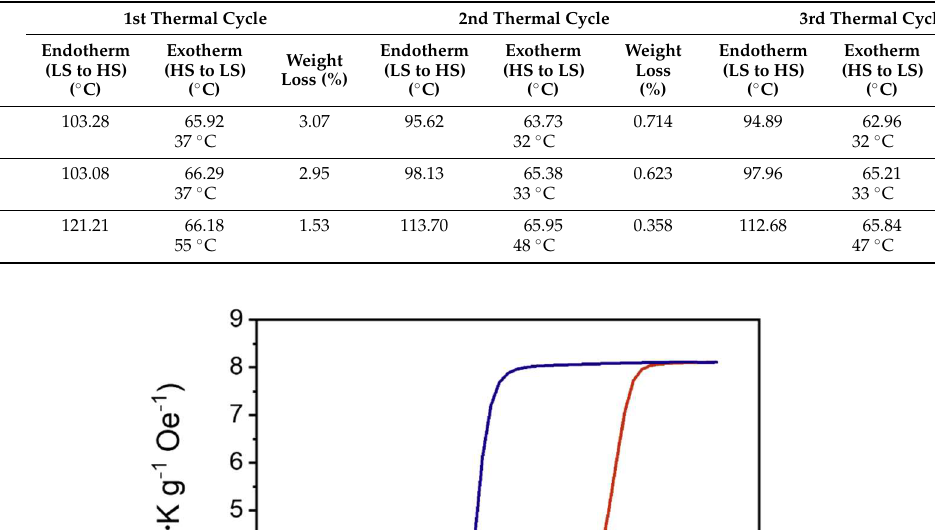
Table 1. Summary of all the DSC and TGA weight loss data obtained for nanoparticles (Samples 1 and 2) and bulk samples (Sample 3) of [Fe(Htrz) 2 (trz)](BF 4 )]. Transitions from low spin states to high spin state in nanoparticle samples occur at lower temperatures when compared to the bulk material.